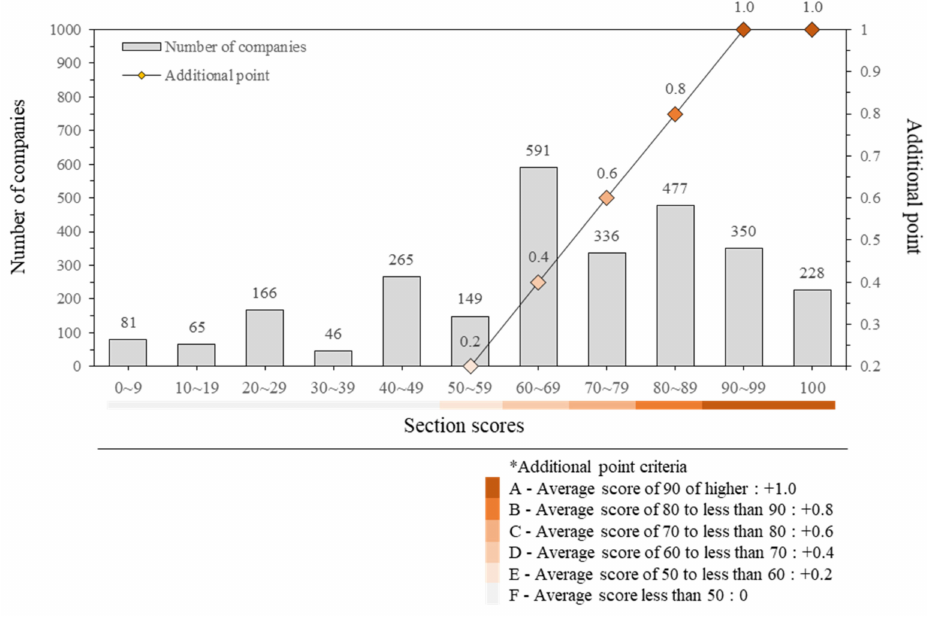
Figure 4. Distribution by participating companies’ evaluation points.